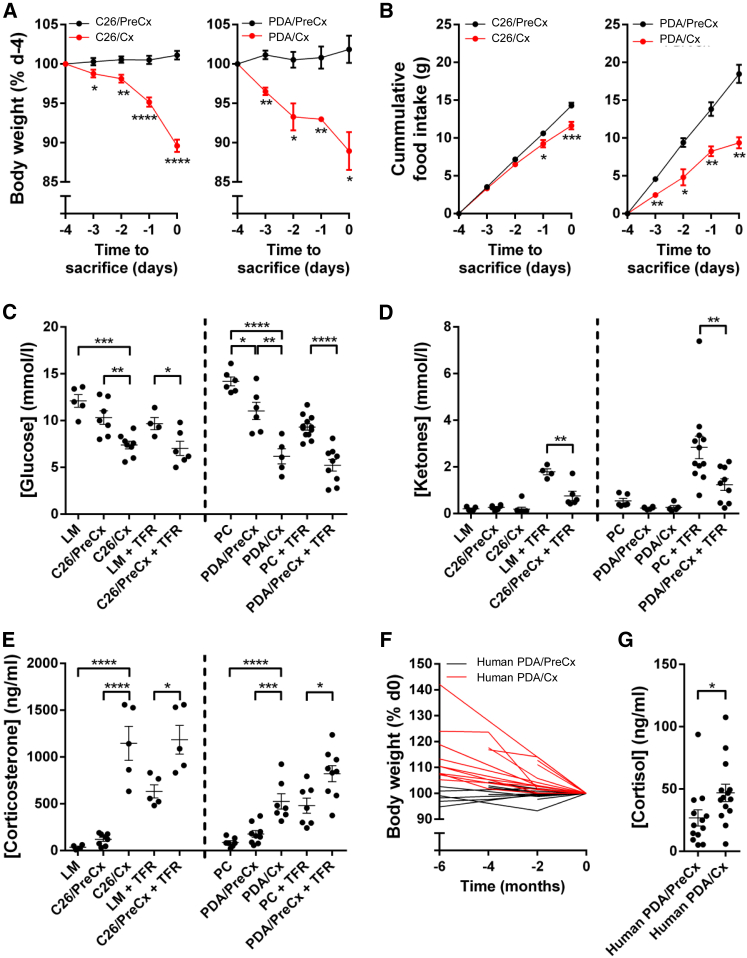
The Metabolic Response to Spontaneous or Imposed Food Restriction of Pre-cachectic Mice Bearing Transplantable C26 Tumors or Autochthonous PDA, and Translational Correlates in Patients with PDAWeight-stable mice with established C26 or PDA tumors that were yet to develop cachexia were termed pre-cachectic (C26/PreCx and PDA/PreCx, respectively). C26- and PDA-bearing mice were termed cachectic (C26/Cx and PDA/Cx, respectively) following >5% body weight loss from their peak weight.(A and B) Body weight (A) and cumulative food intake (B) were monitored in C26/PreCx, C26/Cx, PDA/PreCx, and PDA/Cx mice, and measurements were aligned to the time of sacrifice.(C–E) Terminal bleed plasma levels of (C) glucose and (D) ketones and tail bleed plasma levels of (E) corticosterone were assessed in littermates (LM), C26/PreCx and C26/Cx mice, and LM and C26/PreCx mice that had been subjected to 24 hr TFR (LM + TFR and C26/PreCx + TFR, respectively). Parallel assessments were performed in PDA-bearing mice, with LSL-Trp53R172H/+; Pdx-1-Cre/+ (PC) mice as the non-tumor-bearing controls.(F) Longitudinal pre-sampling weights for pre-cachectic and cachectic patients with pancreatic cancer are displayed.(G) Midday serum cortisol levels for both groups of patients are shown. The comparisons of data for LM, C26/PreCx, and C26/Cx mice, and for PC, PDA/PreCx, and PDA/Cx mice, were performed using one-way ANOVA with Tukey’s correction for post hoc testing. The LM + TFR versus C26/PreCx + TFR, PC + TFR versus PDA/PreCx + TFR, and pre-cachectic versus cachectic patient comparisons were each performed separately using two-tailed t tests with Welch’s correction.∗p < 0.05, ∗∗p < 0.01, ∗∗∗p < 0.001, ∗∗∗∗p < 0.0001. Data are presented as mean ± SEM.